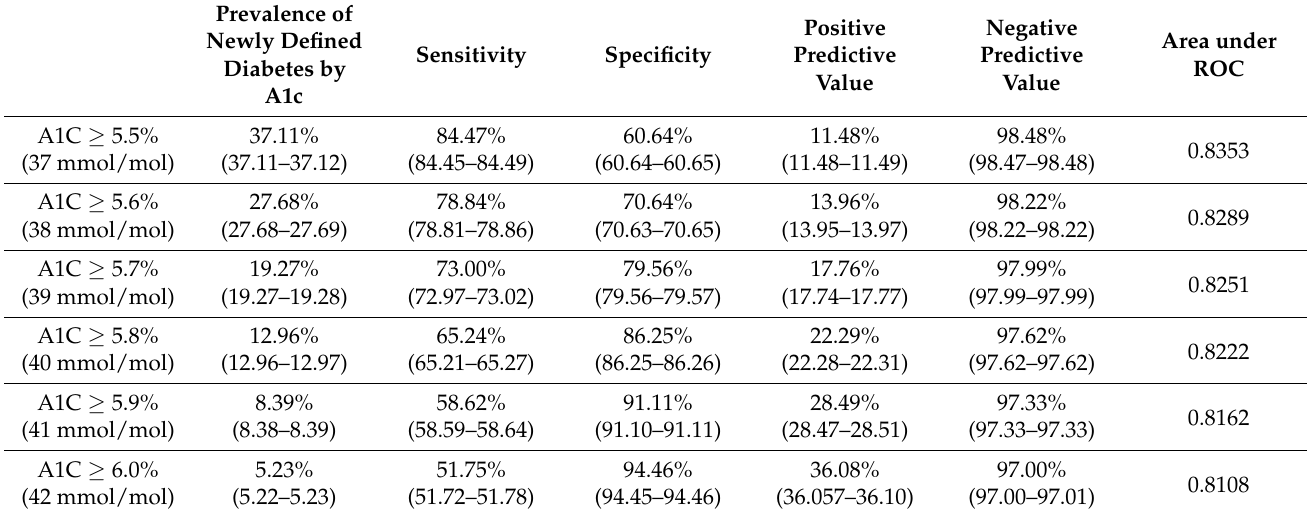
Table 4. Weighted prevalence of newly defined diabetes by A1C, sensitivity, specificity, positive predictive value, negative predictive value with 95% confidence intervals, and the area under ROC curve based on different A1C criteria in comparison to the fasting and 2-h postchallenged plasma glucose criteria in subjects without a prior diagnosis of